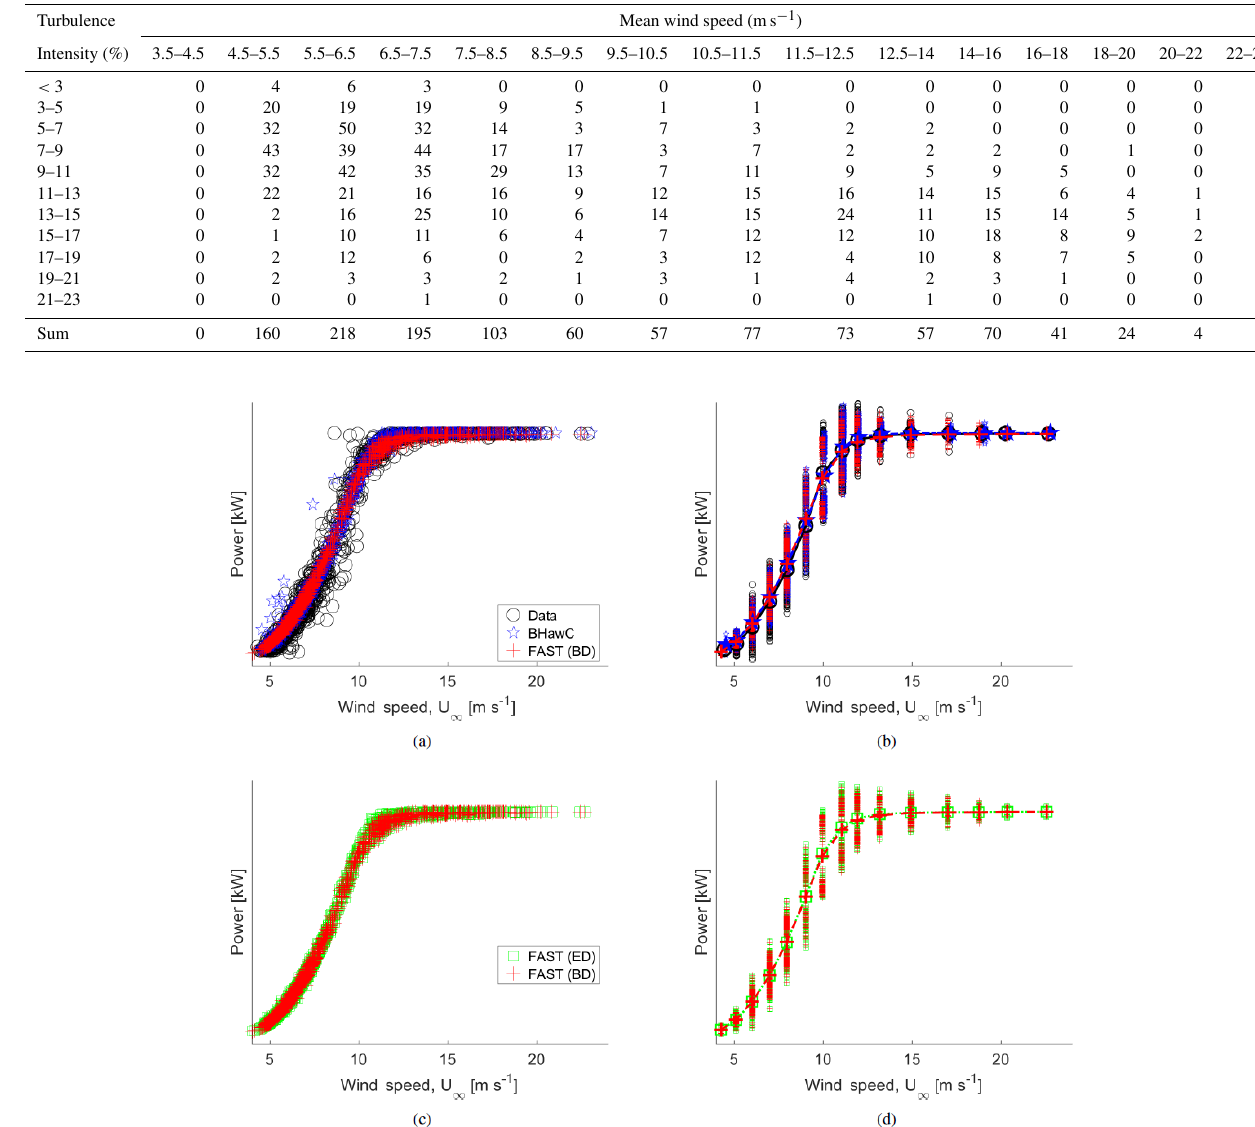
Table 1. International Electrotechnical Commission (IEC) matrix populated with data bins defined by mean wind speed and turbulence intensity. The numbers in the table represent the number of 10min data sets within each bin, for a total of 1141 cases. Turbulence Mean wind speed (ms − 1 )